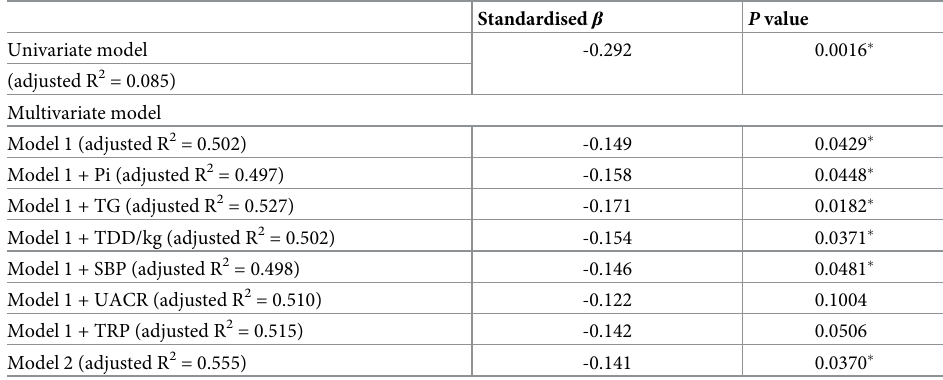
Table 3. Association between FGF23 and eGFR in patients with type 1 diabetes.